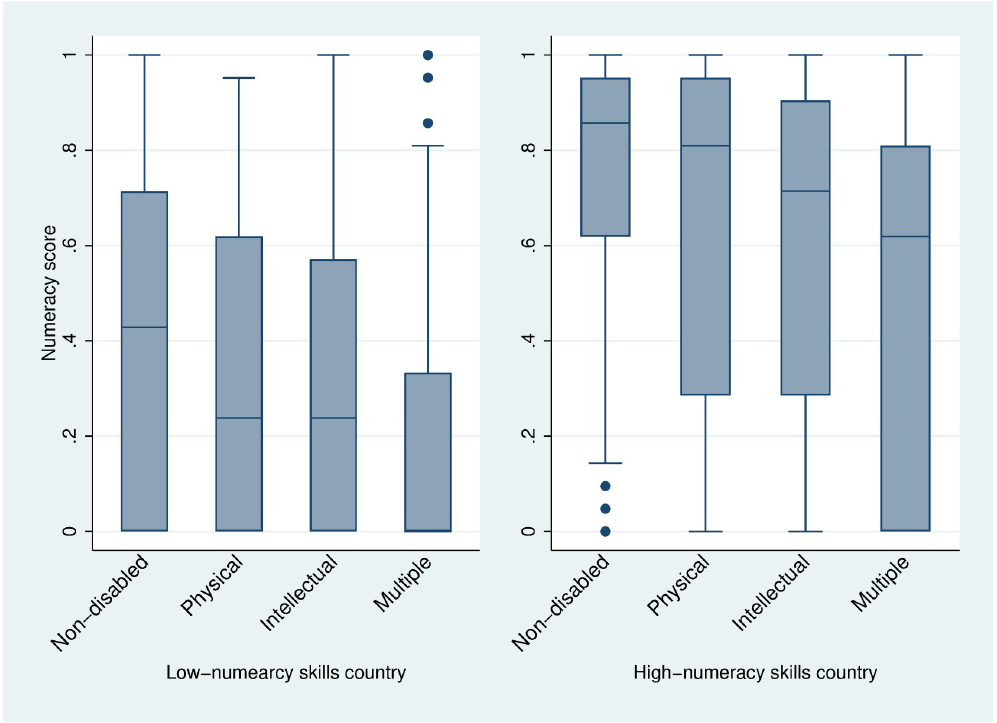
Fig 3. Numeracy test scores in low- and high-numeracy skills countries (median, 25 th and 75 th percentile).